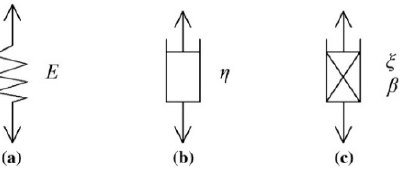
Figure 6. Fundamental mechanical elements with their characteristic parameters: ( a ) Spring element represented by Hooke’s body to reflect the elastic behavior of rocks, E is elastic modulus; ( b ) Dashpot element illustrated by Newton’s body to reflect the viscous behavior of rocks, η is viscosity coefficient; ( c ) Friction-cohesive element represented by St Venant’s body to express the plastic behavior of rocks, ξ is viscosity coefficient; β is fractional order. (Reprinted from [21], Copyright©2022, with permission from the publisher, License No. 5333740277281). Table 3. Common mechanical models interpreting the creep behavior of rocks.